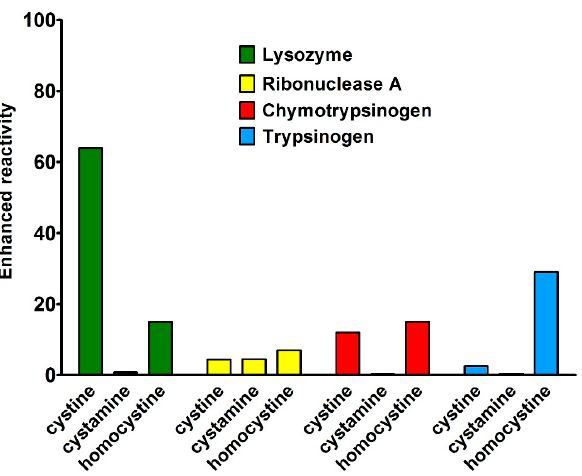
Figure 3. Reactivity of protein cysteines toward natural disulfides. The enhanced reactivity represents the second-order kinetic constants normalized to that of GSH. All proteins did not show any evident hyper-reactivity except the small enhanced reactivity found in Lysozyme toward cystine (65 times) which is small compared to the one of Cys94 toward GSSG (about 3000 times).